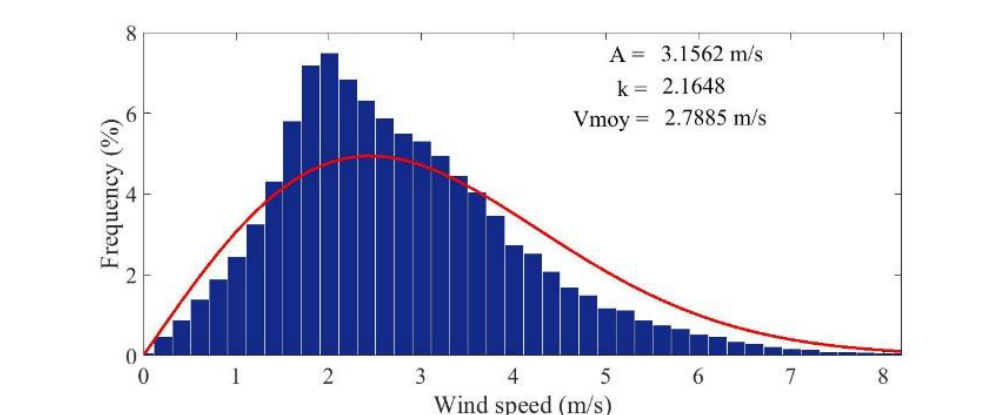
Figure 2. Weibul probability density